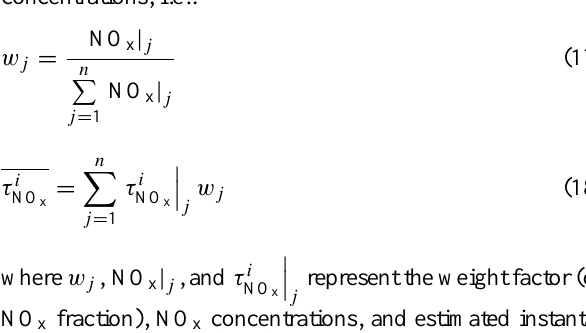
Fig. 10. Sensitivity tests for determining the reaction probability of HNO 3 into sea-salt particles ( γ HNO3 ,ss ). γ HNO 10 − 1 to 10 − 2 . The first, second, and third columns represent the comparison results with γ HNO at transects A to